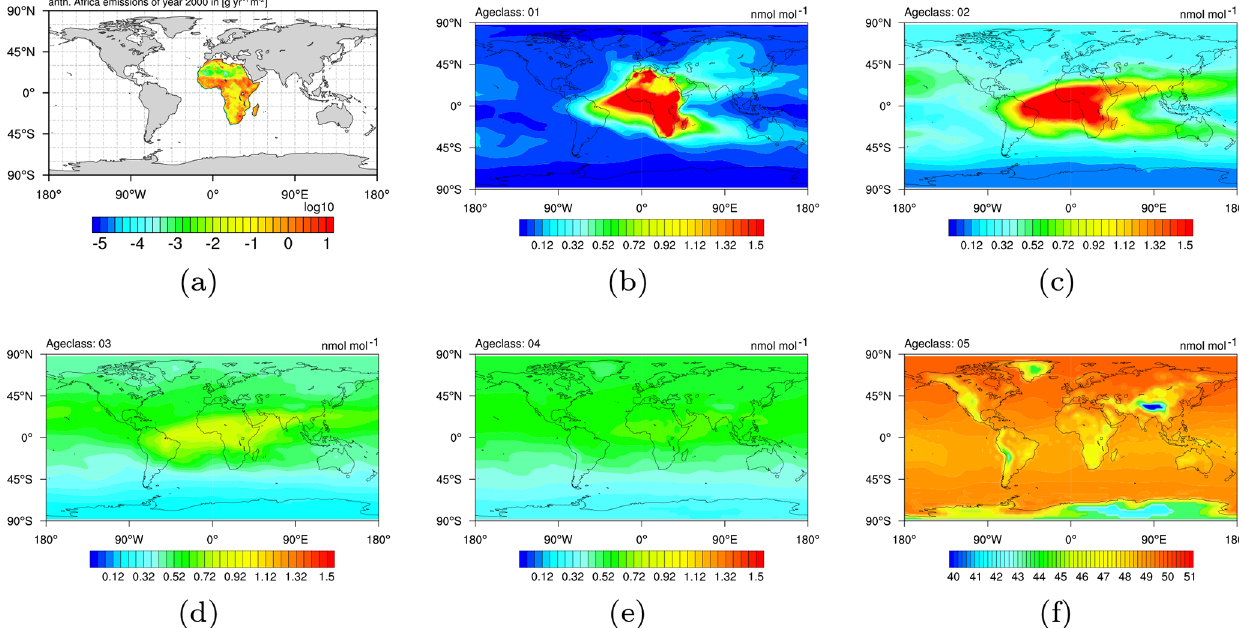
Figure 4. (a) Anthropogenic emissions in Africa (taken from EDGARv4.2 2010 fast-track database; Olivier and Janssens-Maenhout, 2012). (b–f) Methane as a pressure-weighted column up to 200hPa of anthropogenic origin from Africa, distributed into five age classes, i.e. up to 1, 2, 3, and 4, and ≥ 5 months after emission release. As an example, all age classes of January 2000 after the simulation has run for 12 years are